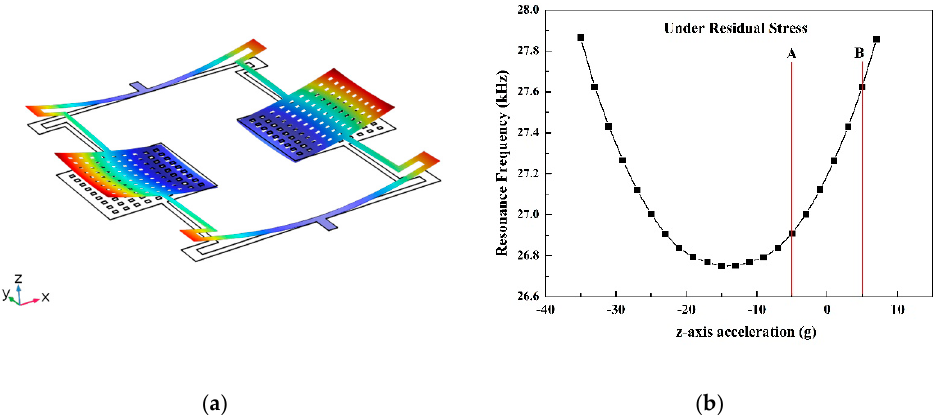
Figure 5. The deformation of the structure under the residual stress ( a ); the sensitivity curve of this AlN MEMS accelerometer simulated with the residual stress ( b ).